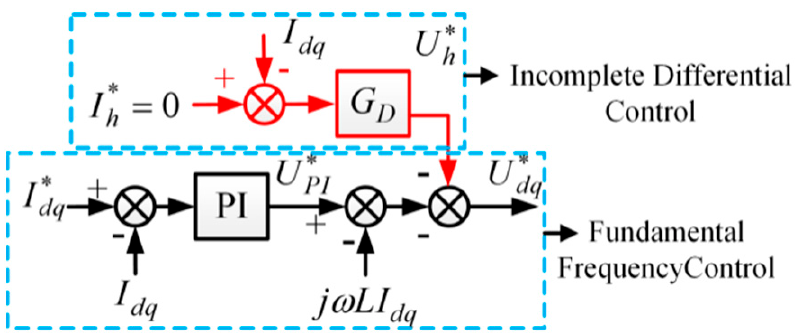
Figure 6. Control block diagram of U dq .